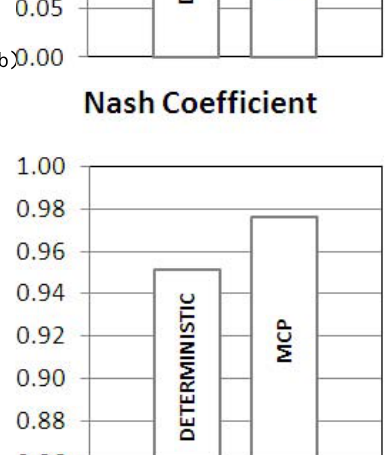
actually overtopped the threshold (a warning threshold in this case). The lower section of Fig. 9 shows the observed values (continuous line), the deterministic forecast (dotted line) and the expected value conditioned to the model forecast (dashed line), as well as the 90 % uncertainty band (grey area) and the alarm threshold set to 0 m (horizontal dashed line). The up- per section represents the probability of exceeding the alarm threshold, the observed binary response (continuous line)